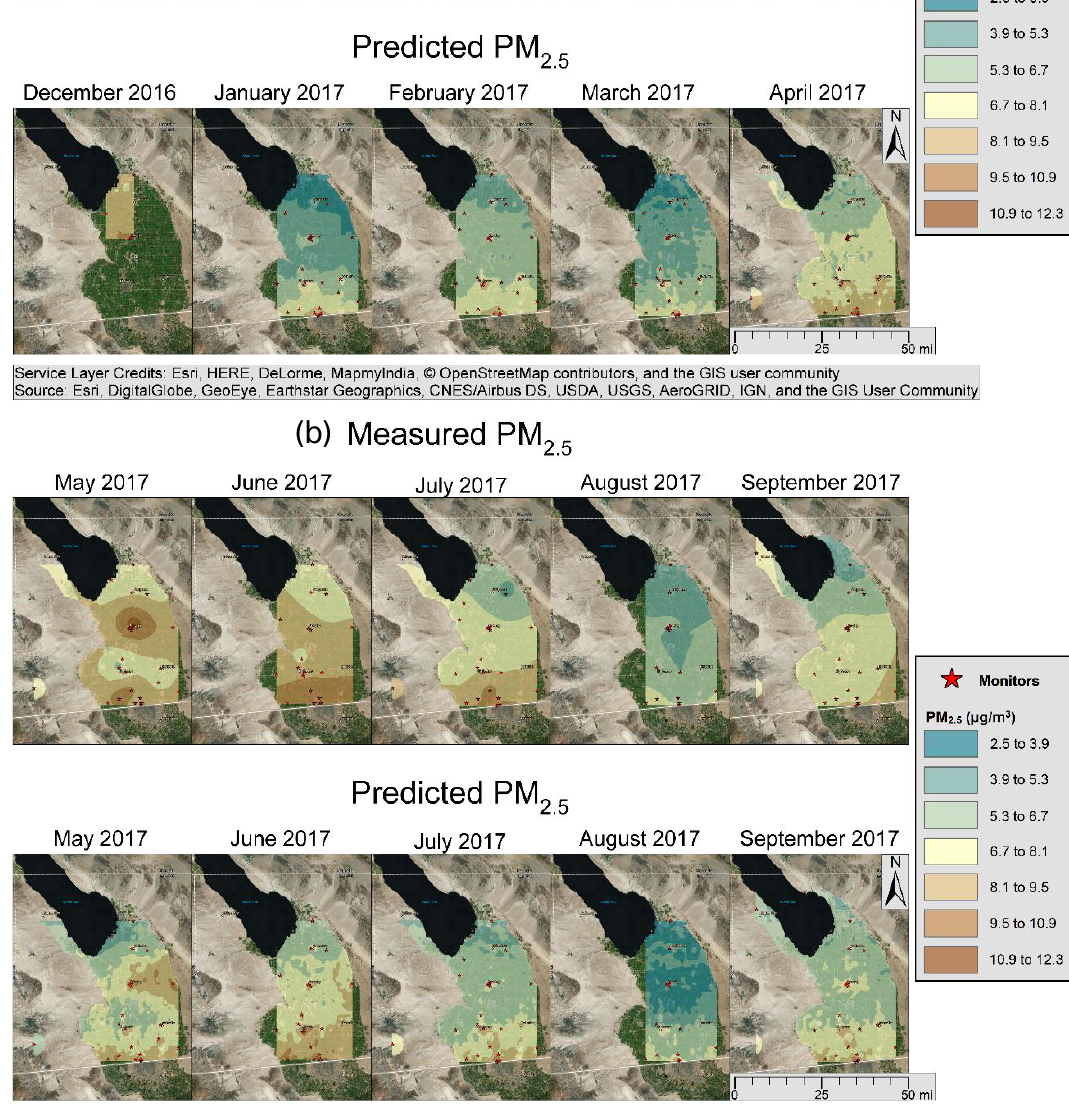
Figure 4. ( a ) Monthly measured and predicted PM 2.5 (December–April 2017); ( b ) monthly measured and predicted PM 2.5 (May–September 2017). Figure 5a,b show maps of monthly measured and predicted PM coarse . The predicted PM coarse map is a sum of the PM coarse model and the kriged PM coarse residuals. There was good spatial agreement between the PM coarse measurements and predictions; however, the predictions were